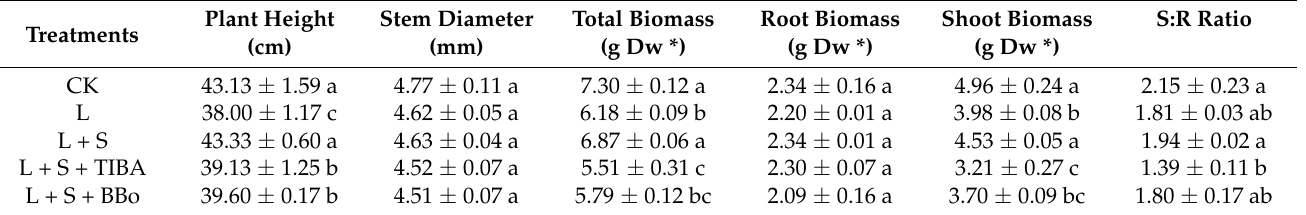
Table 2. Effects of exogenous sucrose and IAA inhibitors on the growth parameters of M. baccata under sub-low temperature.